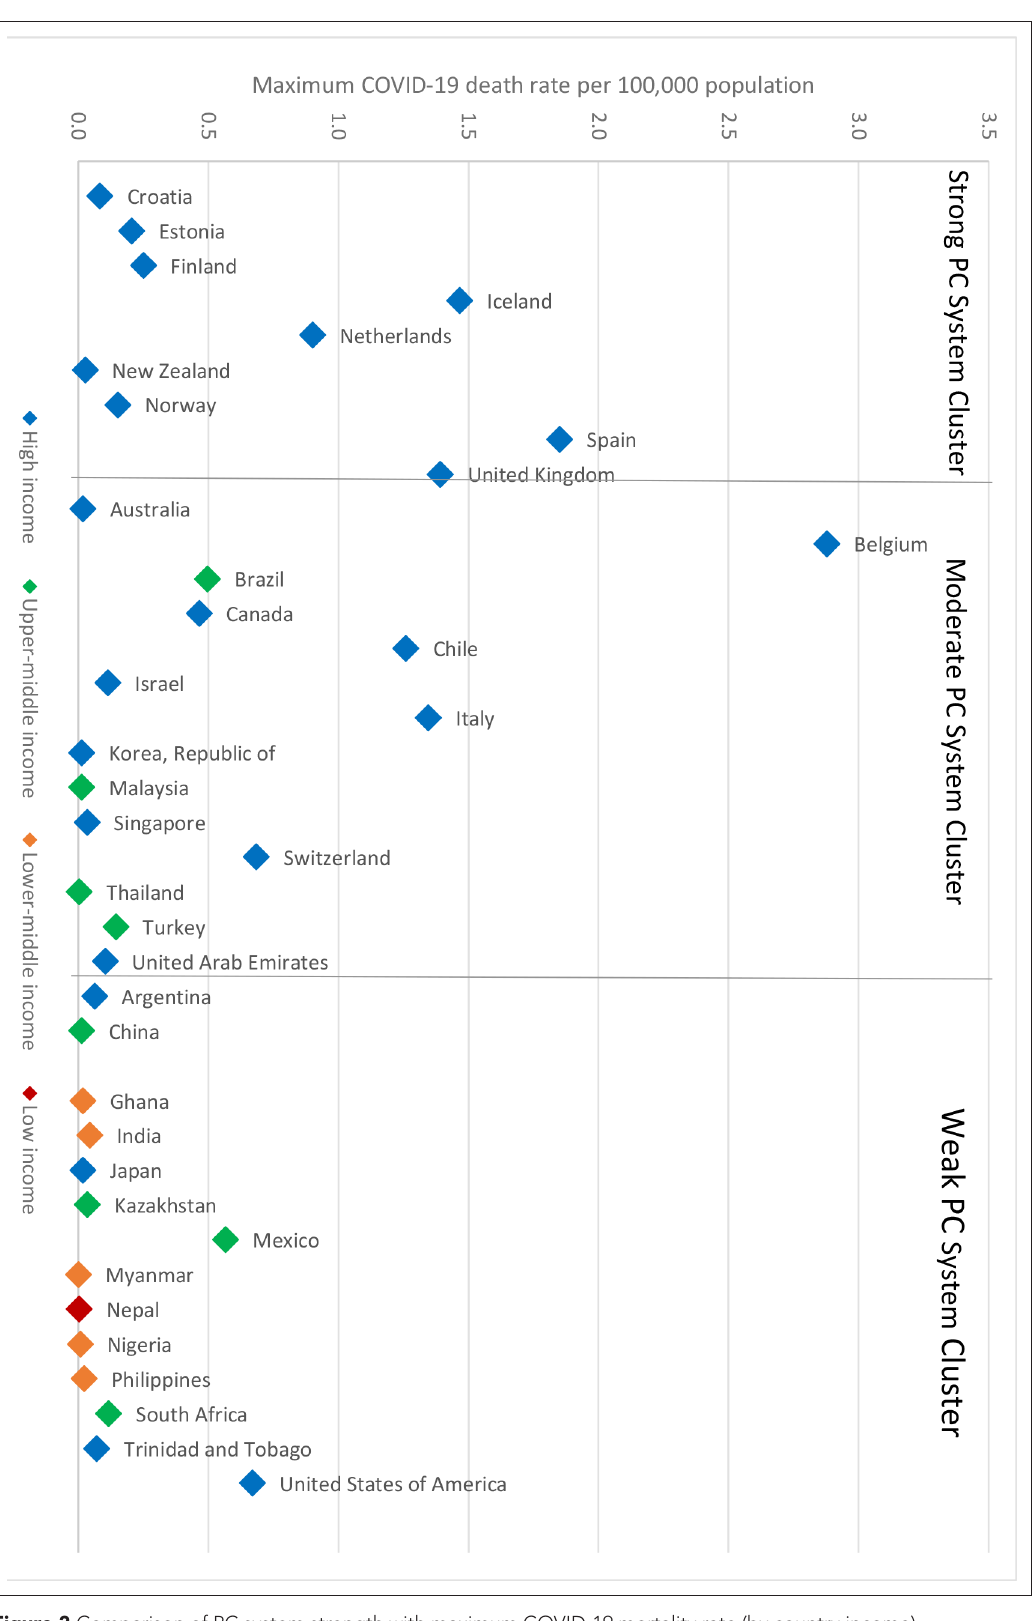
Figure 2 Comparison of PC system strength with maximum COVID-19 mortality rate (by country